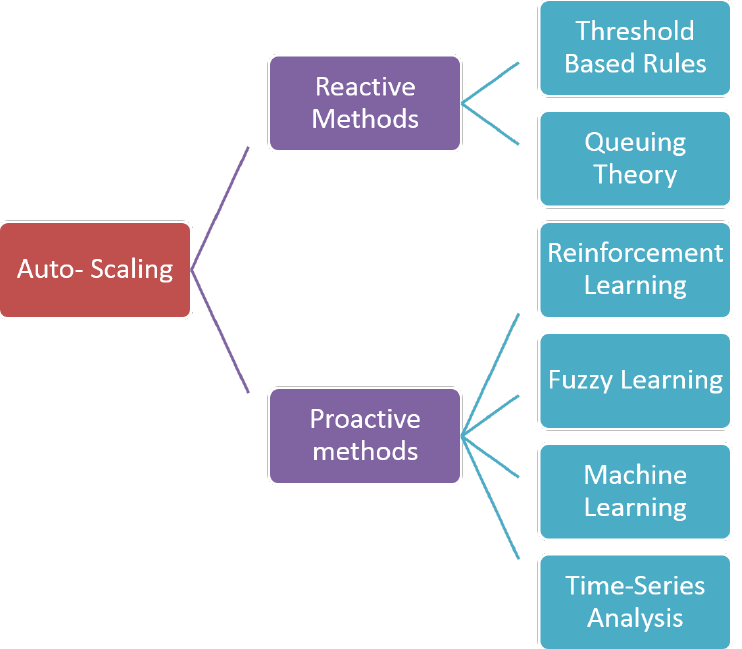
Figure 1. Common auto-scaling techniques for reactive and proactive